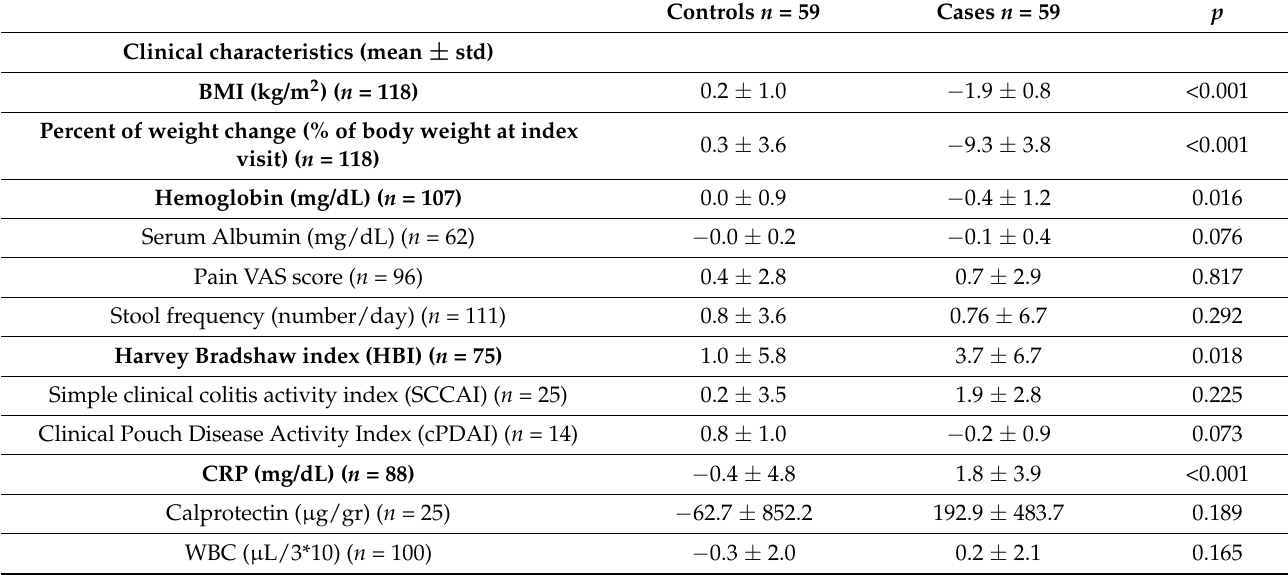
Table 3. Changes ( ∆ ) in nutritional and clinical characteristics between visits, among cases and